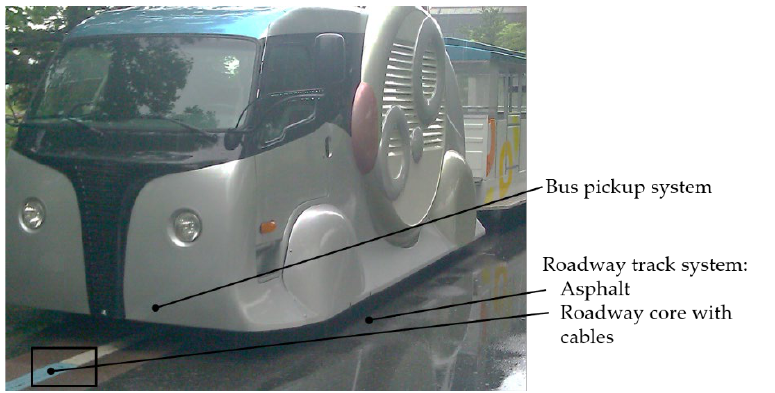
Figure 1. Roadway track system of the KAIST project.